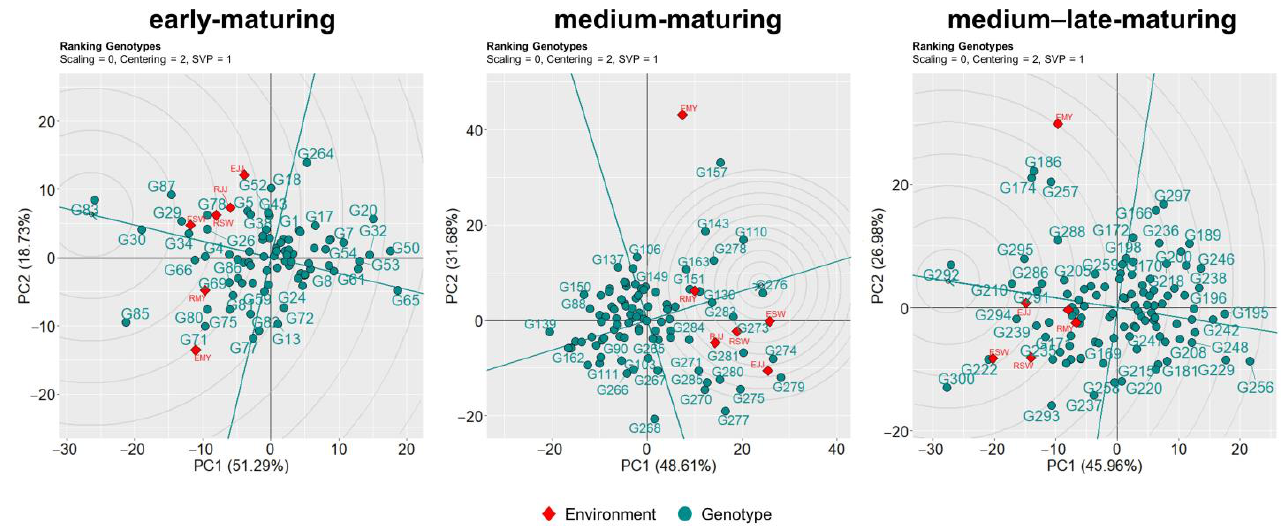
Figure 4. ‘Ranking genotypes’ view of GGE biplots for grain yield of early-, medium-, and medium–late-maturing cultivars. Red diamonds represent environment. Green circles and green lines indicate individual genotype and average environment axis, respectively. EJJ—early planting in Jeonju;